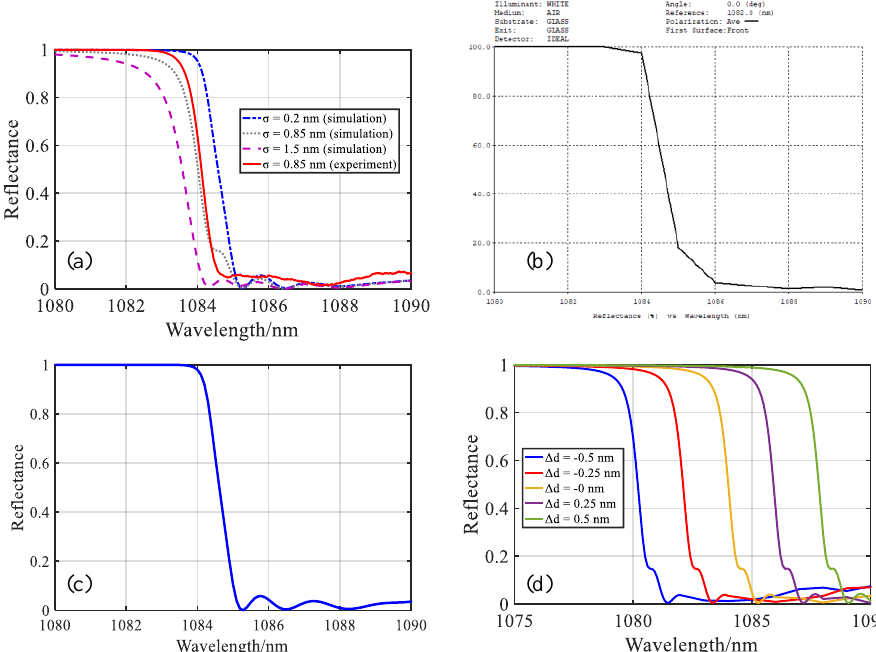
Figure 4. ( a ) The reflectance curves of the edge filter under different surface roughness values. The simulation results of the reflectance curve of the edge filter with smooth surface, obtained with: ( b ) TFCalc; ( c ) uncorrelated surface roughness model. ( d ) The reflectance curve of the edge filter versus the thickness error.